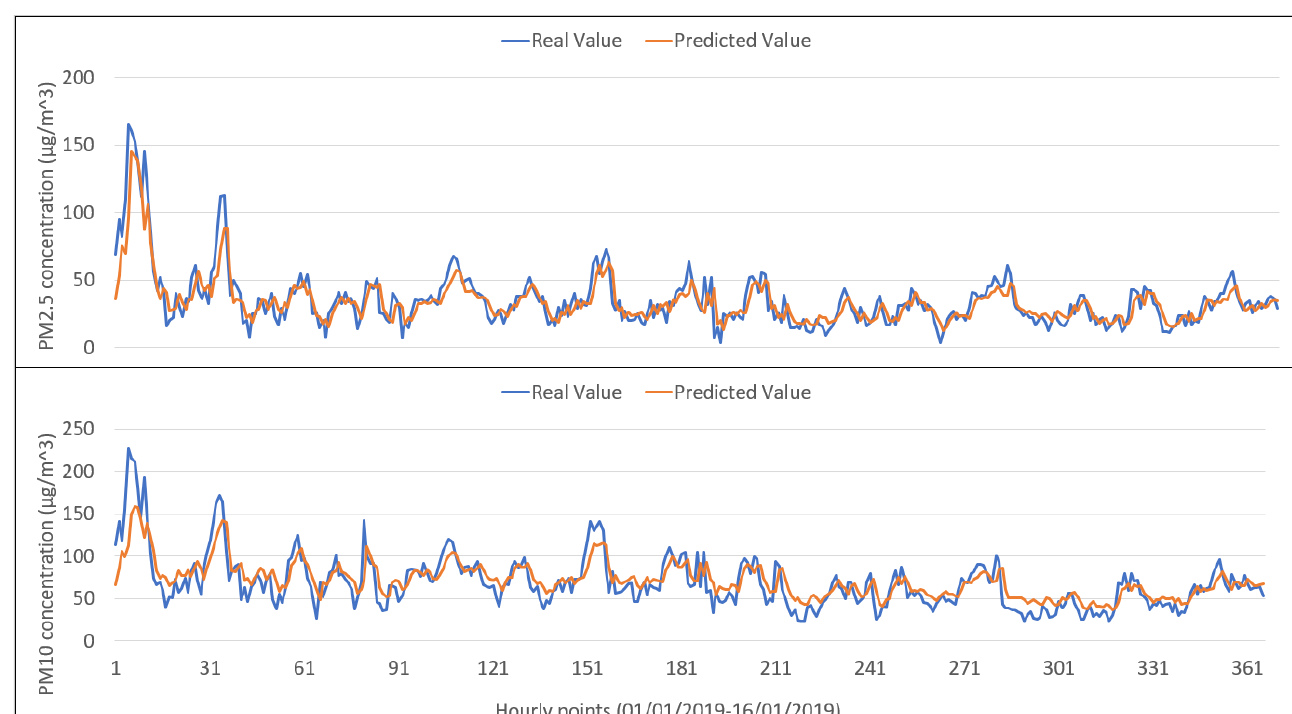
Figure 7. Behavioral comparison of real data and data modeled by the LSTM network.